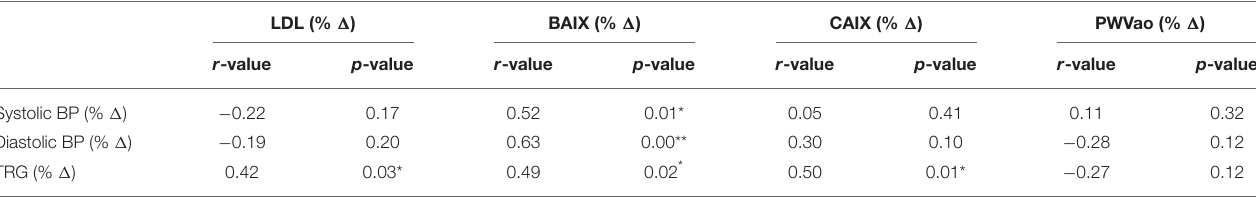
TABLE 8 | Pearson correlation coefficients for the percent change in variables following the phase 2